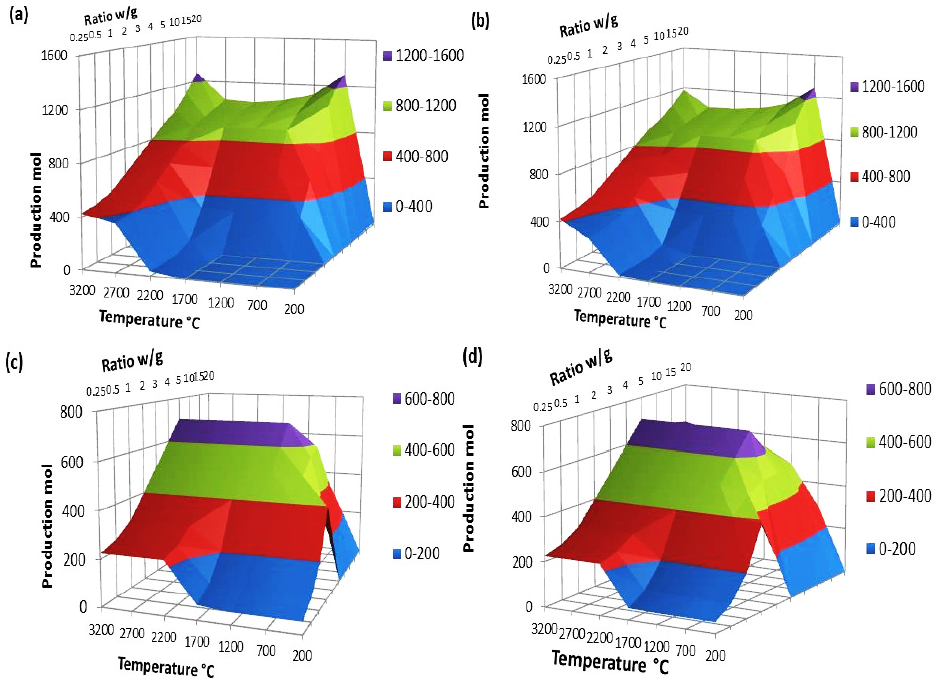
Figure 3. Production of H 2 at ( a ) 0.05 and ( b ) 0.1 MPa; production of CO at ( c ) 0.05 and ( d ) 0.1 MPa.